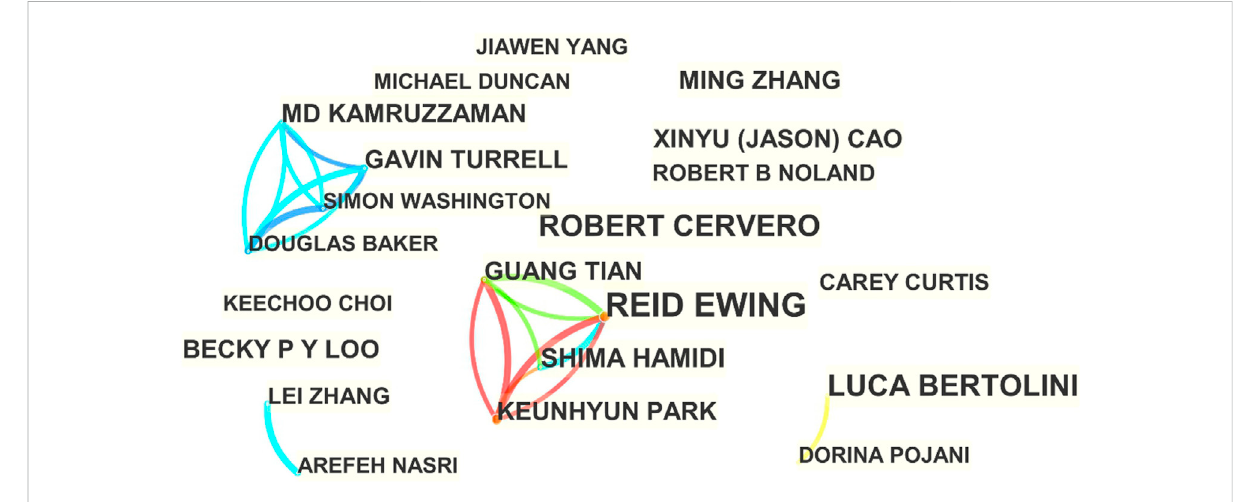
FIGURE 4 Network map of author cooperation in the TOD fi eld.